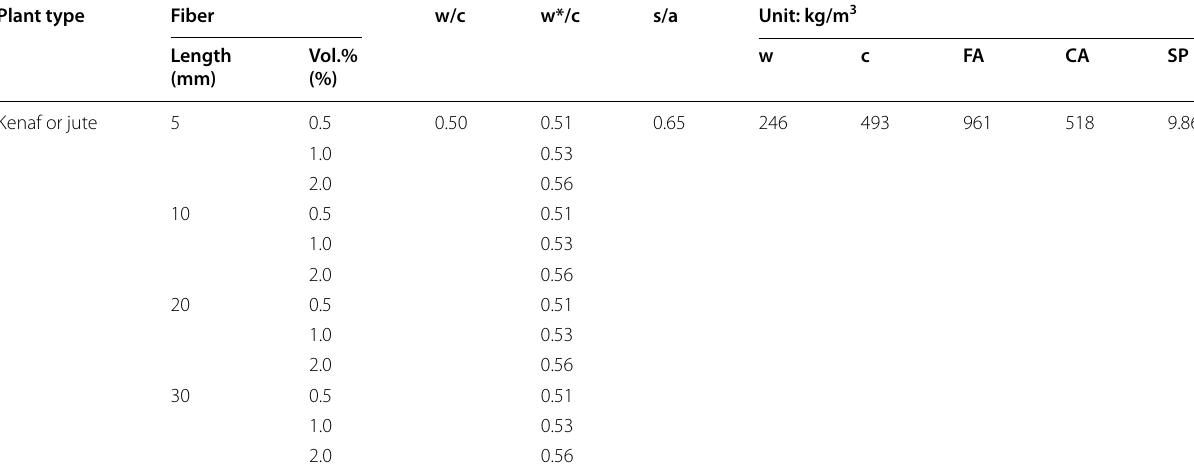
w water, w* effective water, c cement, s/a sand-to-aggregate, FA fine aggregate (river sand), CA coarse aggregate, SP : superplasticizer